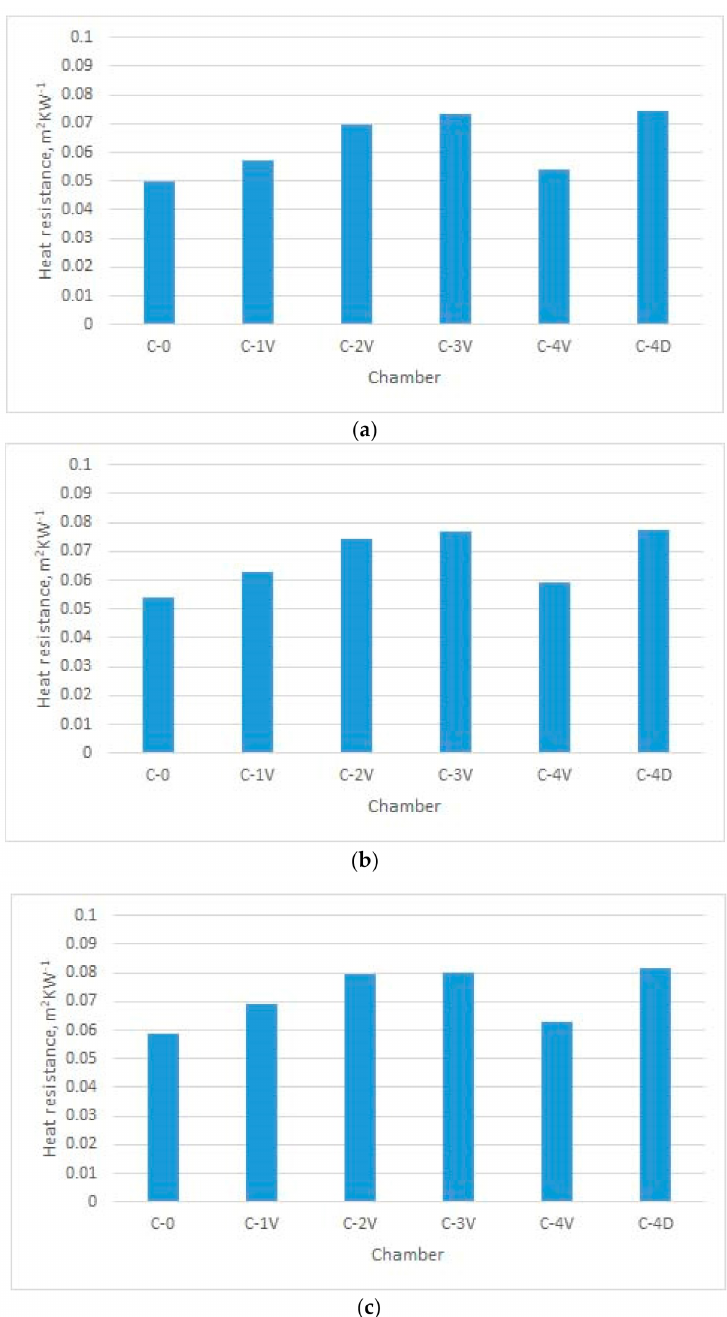
Figure 11. Heat resistance of designed noninflated PICs at different ambient temperatures (T): ( a ) T = 20 ◦ C; ( b ) T = 15 ◦ C; ( c ) T = 10 ◦